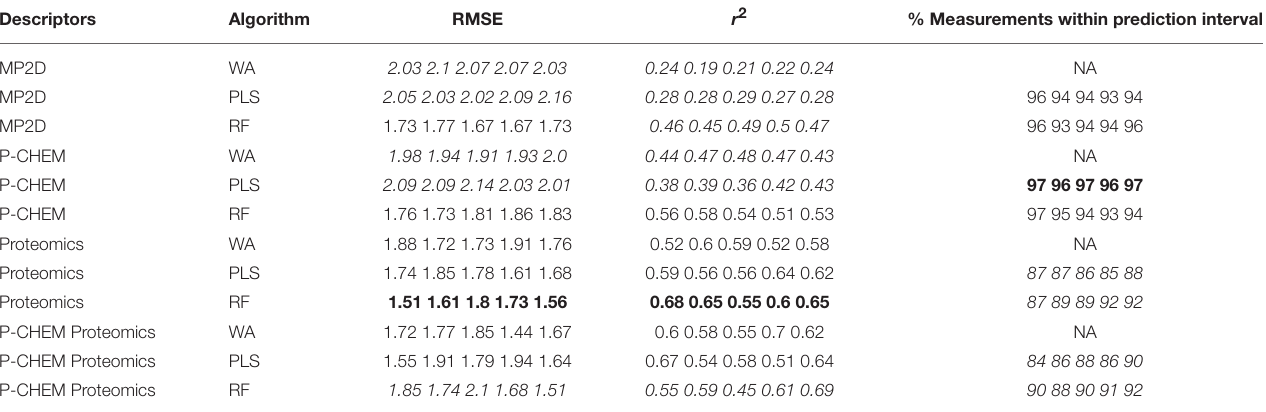
TABLE 1 | Results from five independent crossvalidations for various descriptor/algorithm combinations.